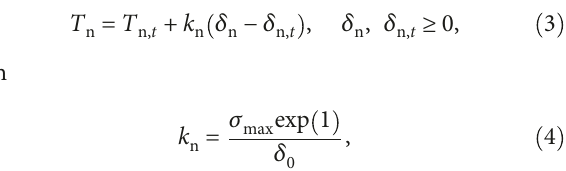
Figure 2: Illustration of the loading-unloading-reloading path together with (a) the cyclic loading spectrum at (b) δ (c) δ n > δ 0 ( fi rst half cycle): loading with opening of the cohesive surface (1 → 2); unloading (2 → 3); reloading with the damage accumulation (3 → 4); and subsequent partial unloading (4 → 5). The dot lines represent the degraded cohesive